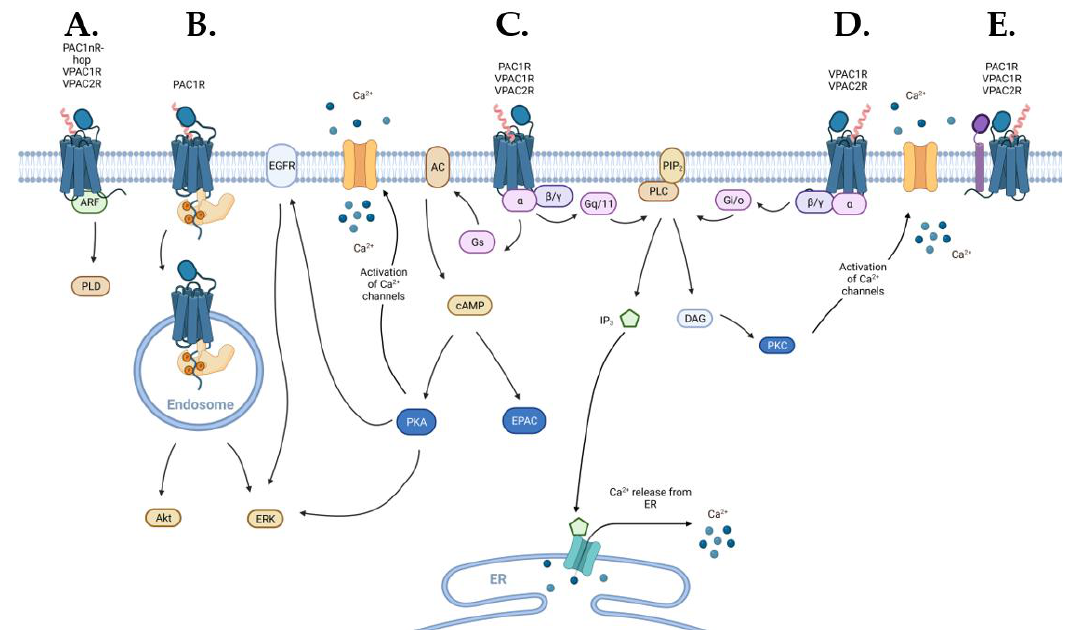
Figure 1. Schematic diagram of the signaling pathways activated by the PACAP subfamily of recep- tors (blue): ( A ) VPACRs and the PAC1R splice variant PAC1nR-hop can engage ADP-ribosylation factor (ARF) signaling, ( B ) endosomal signaling may be activated by β -arrestin (light-orange) re- cruitment to PAC1R, ( C ) VPAC1R, VPAC2R, and PAC1R directly engage G s - and G q/11 -coupled pathways, ( D ) VPAC1R and VPAC2R also directly activate G i/o -coupled pathways, and ( E ) PACAP subfamily of receptors can interact, in a receptor-specific manner, with receptor activity-modifying protein (RAMP) (purple) that can alter receptor signaling or trafficking. Abbreviations used in this figure: ARF — ADP-ribosylation factor, PLD — phospholipase D, ERK — extracellular signal-regu- lated kinase, EGFR — epidermal growth factor receptor, AC — adenylate cyclase, cAMP —3′ , 5′ -cyclic adenosine monophosphate, PKA — protein kinase A, EPAC — exchange protein directly activated by cAMP, Ca 2+ — calcium, PLC — phospholipase C, PIP 2 — phosphatidylinositol 4,5-bisphosphate, IP 3 — inositol 1,4,5-trisphosphate, DAG — diacylglycerol, ER — endoplasmic reticulum, PKC — protein ki- nase C.